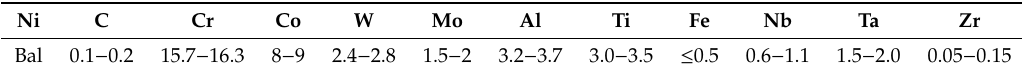
Table 1. Nominal composition of the superalloy K38 (wt.%).